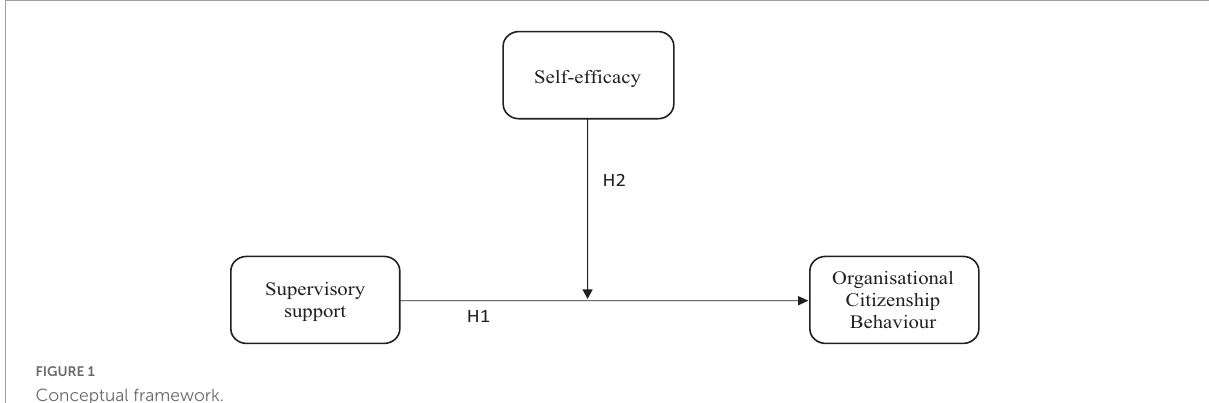
FIGURE1 Conceptual